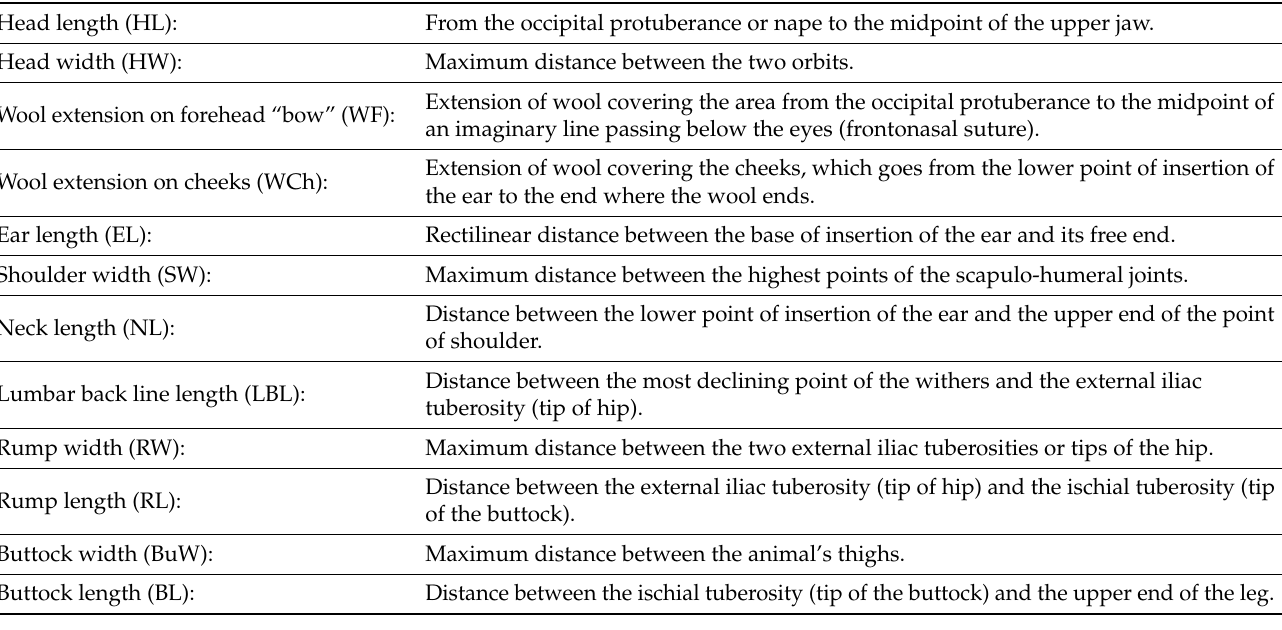
Table 1. Measurements taken with a measuring compass.